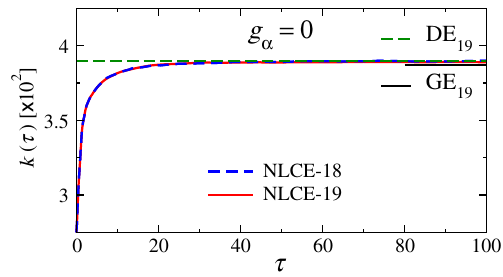
FIG. 2. Dynamics of the one-body nearest neighbor correlation k ð τ Þ when g α ¼ 0 after the quench. Results are shown for the 18th (NLCE-18) and 19th (NLCE-19) orders of the NLCE. We also report, as horizontal lines, the results for the 19th order of the diagonal ensemble (DE 19 ) and for the 19th order of the grand canonical ensemble (GE 19